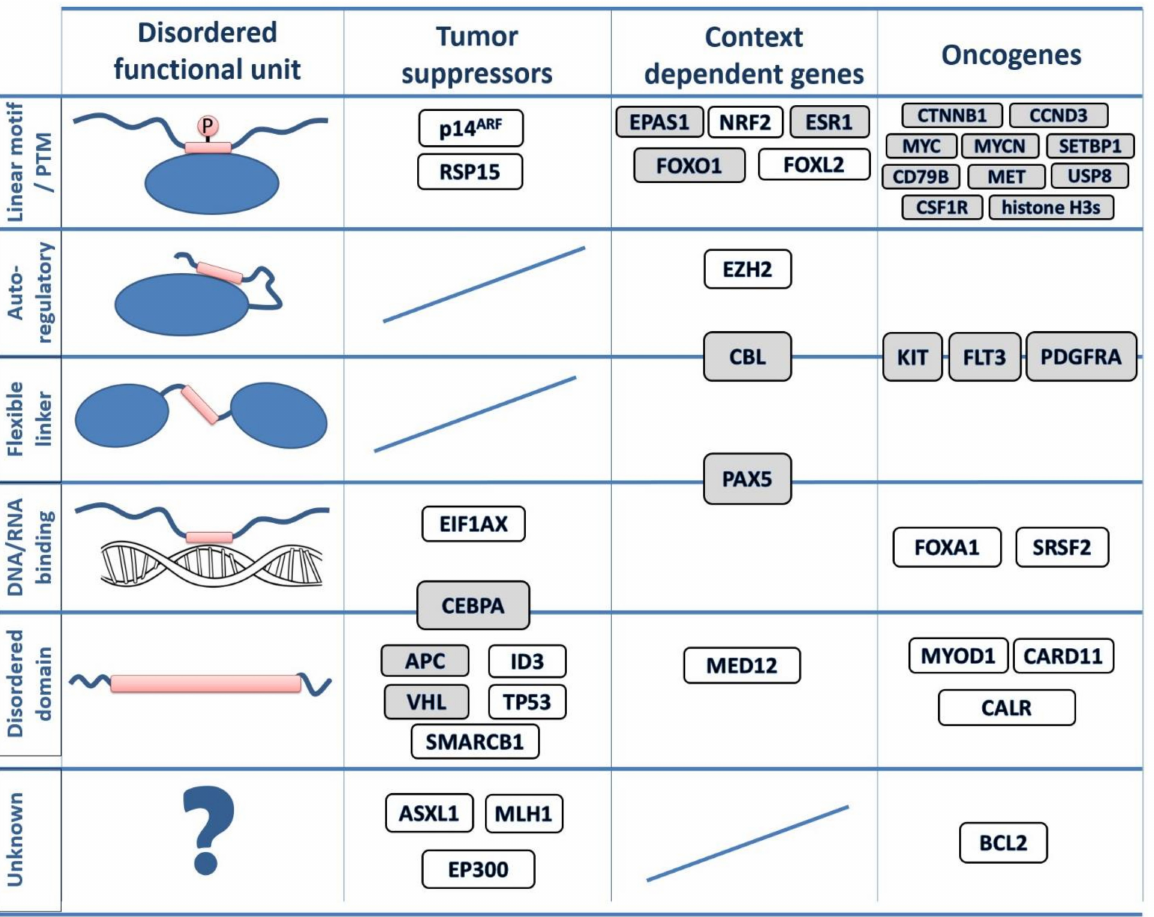
Figure 2. IDP regions mutated in cancer. The classification of identified disordered cancer drivers. Protein names in gray indicate known switching mechanisms either via post-translational modifications (PTMs) or overlapping functions. In protein architecture schematics, blue ovals represent folded domains, blue lines represent disordered regions and red rectangles represent disordered driver modules. Boxes placed between two categories indicate dual functions. For detailed mutation profiles for each gene, see the online visualization links in Supplementary Table